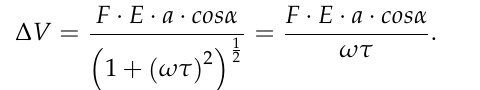
Figure 5. The lysis efficiency decreased when the frequency was increased. The voltage was 6 V p-p and the flow rate was 2 µ L/min. The frequency was changed in the range of 1 kHz–50 MHz. When the frequency was in the range of 1–500 kHz, the efficiency of E. coli lysis was very high (about 90%). With the increase in frequency, the lysis efficiency decreased significantly. After the frequency reached 50 MHz, the bacteria could not be broken, indicating that the high-frequency condition was not suitable for bacteria lysis. This result is consistent with Equation (1), that is, with the decrease in frequency, the transmembrane potential increases gradually, and the lysis efficiency increases